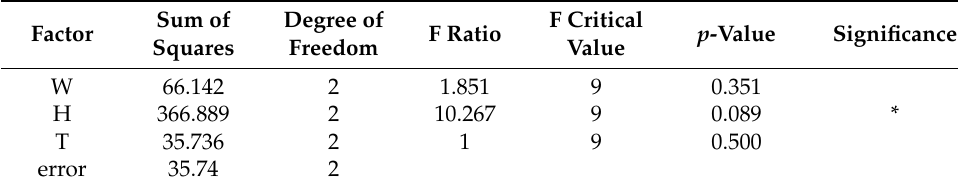
Table 18. The variance of MOR of impregnated heat-treated wood.